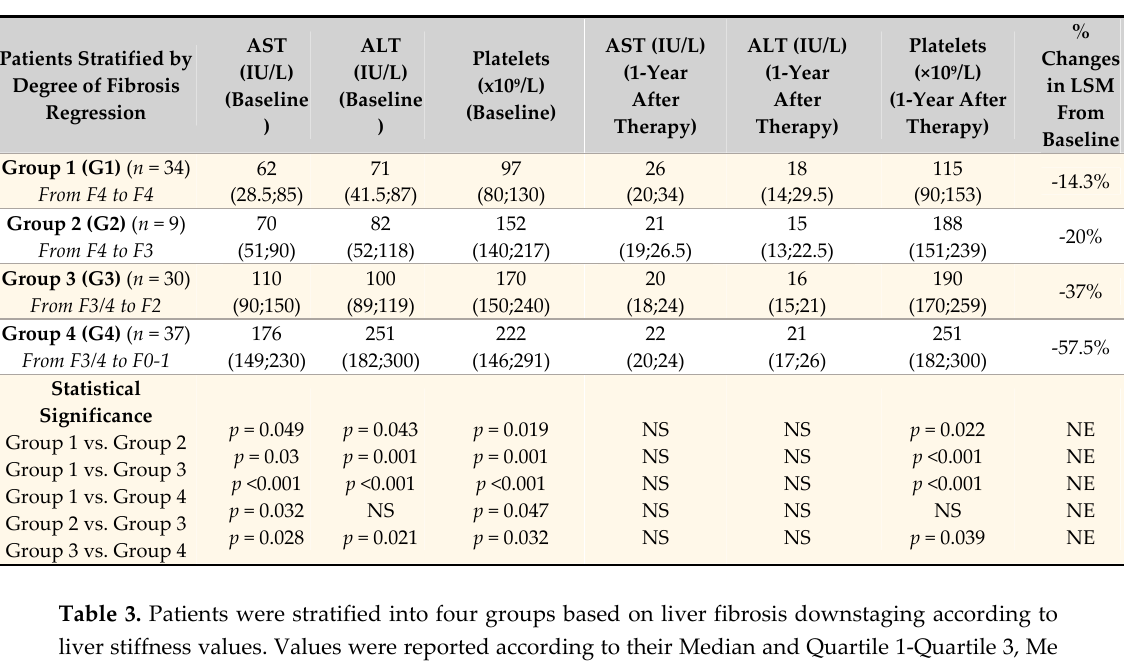
Table 2. Patients were stratified into four groups based on liver fibrosis downstaging according to liver stiffness values. Values were reported according to their Median and Quartile 1–Quartile 3, Me (Q1;Q3). Inter-group differences were evaluated using Mann–Whitney U test. AST: aspartate aminotransferase; ALT: alanine aminotransferase; NS: not statistically significant difference; NE: not evaluated.